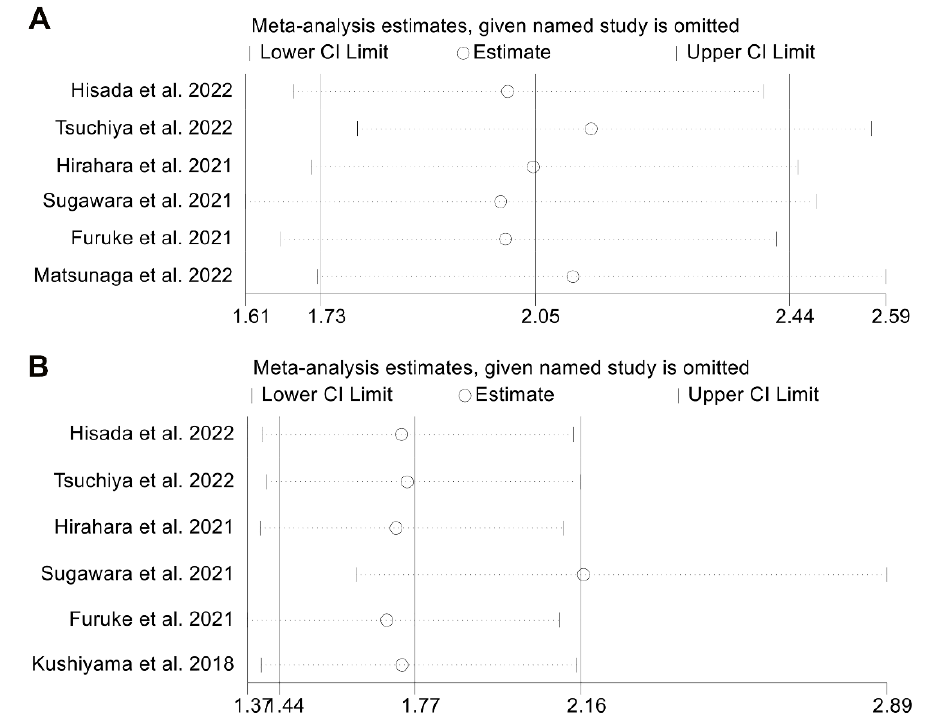
Figure 6. Sensitivity analysis of overall survival ( A ) and postoperative complications ( B ). CL,